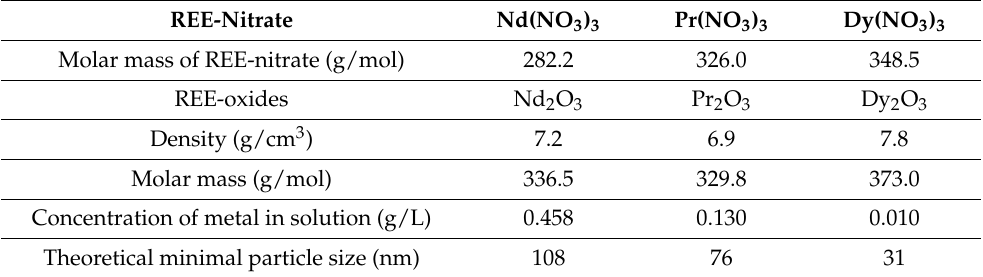
Table 5. Calculated theoretical particle size of RE-oxides using Equation (5).